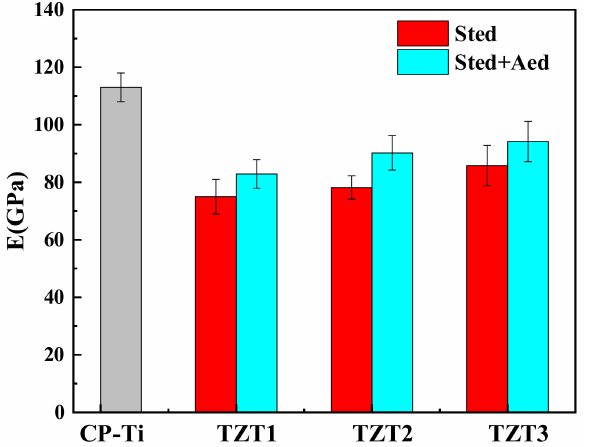
Figure 7. The elastic moduli of the CP-Ti and the TZT1 and TZT2 and TZT3 alloys after solution treatment at 1173 K for 3 h and being aged at 973 K for 6